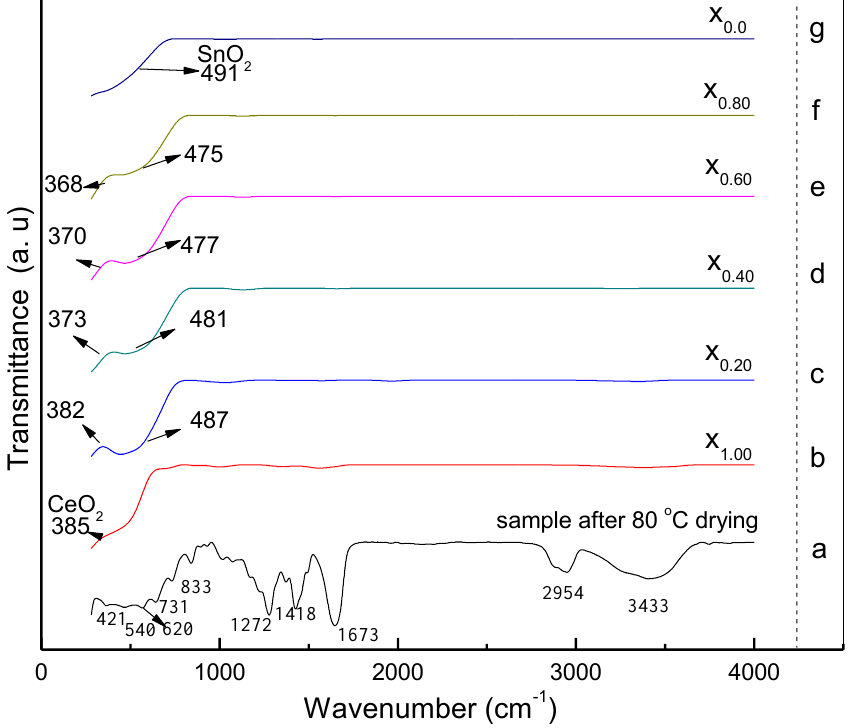
Figure 7. FTIR spectra of ( a ) the sample after drying at 80 °C (( b ), x 1.00 ) Ce 1.00 Sn 0.00 O 2 , (( c ), x 0.20 ) Ce 0.20 Sn 0.80 O 2 (( d ), x 0.40 ) Ce 0.40 Sn 0.60 O 2 , (( e ), x 0.60 ) Ce 0.60 Sn 0.40 O 2 , (( f ), x 0.80 ) Ce 0.80 Sn 0.20 O 2 and (( g ), x 0.00 ) Ce 0.00 Sn 1.00 O 2 nanoparticles calcined at 650 °C.